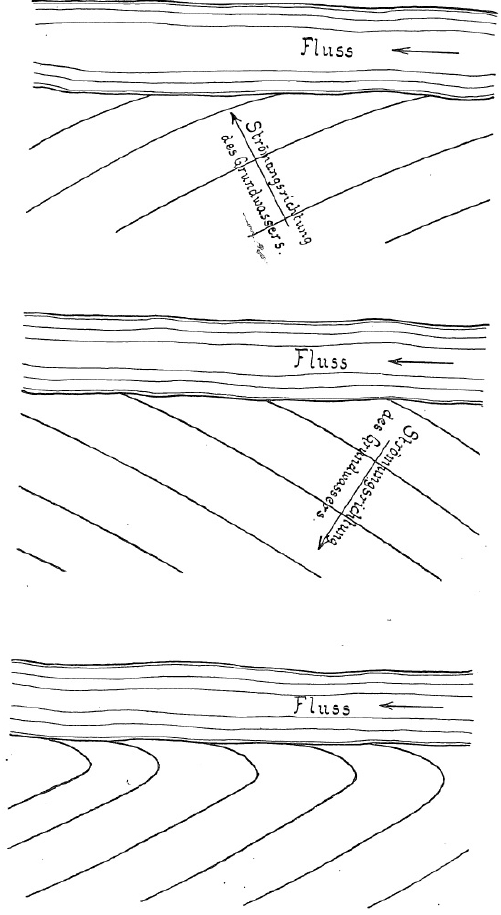
Figure 8. Groundwater–surface water interaction at the Iser (Jizera) river near Prague. At the top, the gaining conditions are shown. In the middle, the losing conditions are shown. At the bottom, the bank infiltration during river flood conditions are shown (Thiem,